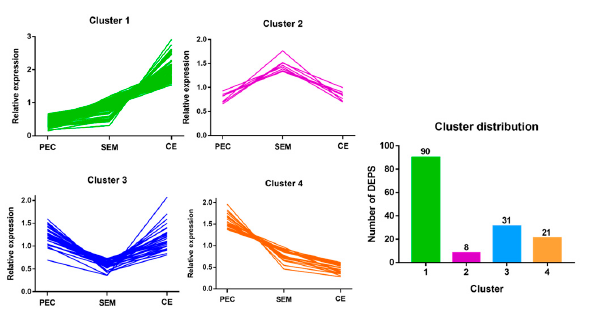
Figure 3. Hierarchical cluster analysis of DEPs. DEPs in PEC, SEM, and CE were classified into four clusters according to their expression patterns.